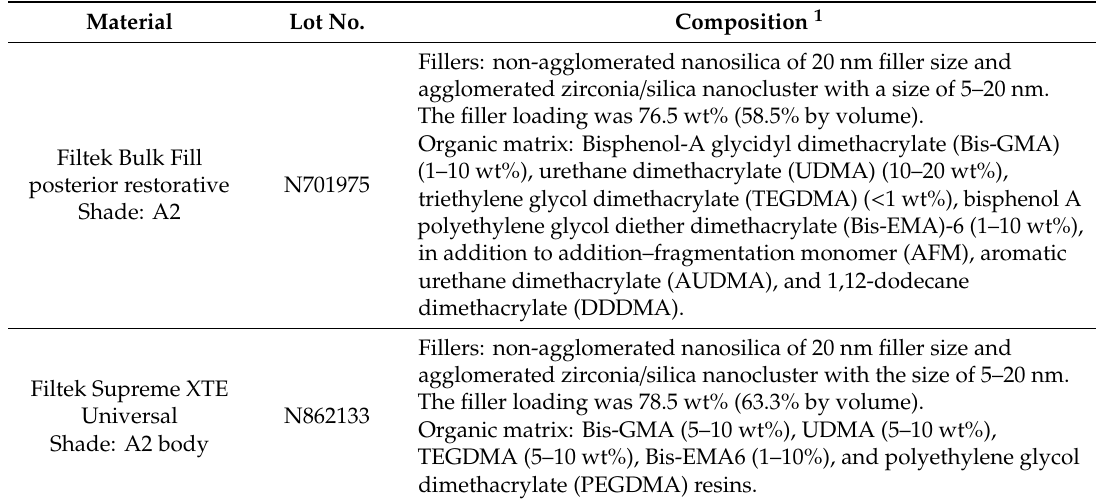
Table 1. Materials used in the study, their lot number, and